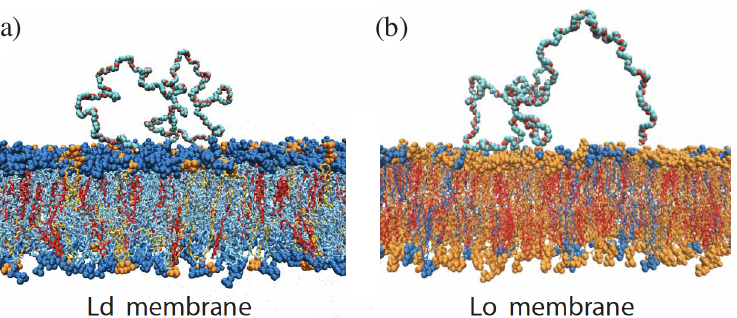
Figure 17. Typical conformations of a single PEG molecule adsorbed to two bilayers with different lipid compositions as observed in atomistic molecular dynamics simulations [9]. The color code for the lipids is blue for DOPC, orange for DPPC, and red for cholesterol. The lipid composition in ( a ) belongs to the liquid-disordered (Ld) phase, which is enriched in DOPC (blue), the one in ( b ) to the liquid-ordered (Lo) phase enriched in DPPC (orange). The PEG chains, which consist of 180 monomers, are only weakly bound to the lipid bilayers, with relatively short contact segments and relatively long loops in between two such segments. The two terminal OH groups of the PEG molecule are often bound to the membrane via hydrogen bonds. The same lipid compositions were studied experimentally in [9], but the polymer solution was semi-dilute and the PEG chains formed an adsorption layer close to the overlap